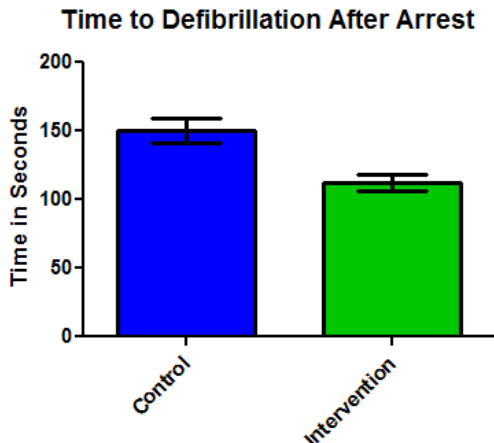
Figure 1. Students with access to computer based simulation did not initiate compressions in the ACLS Megacode faster than students without access.